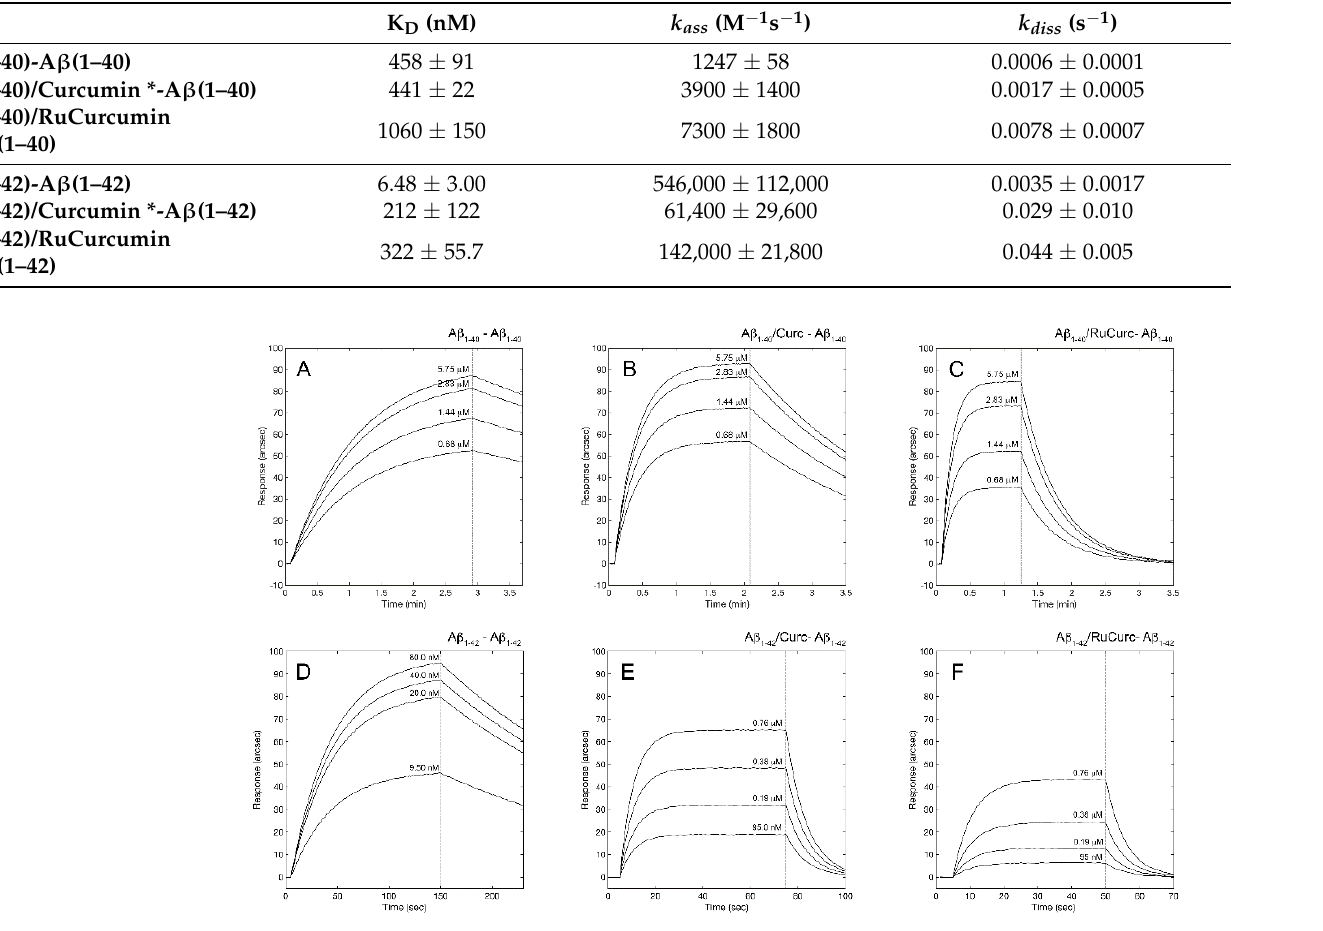
Figure 2. Biosensor binding study. Effect of curcumin and RuCurcumin on the kinetics of A β (1–40) and A β (1–42) dimerization.